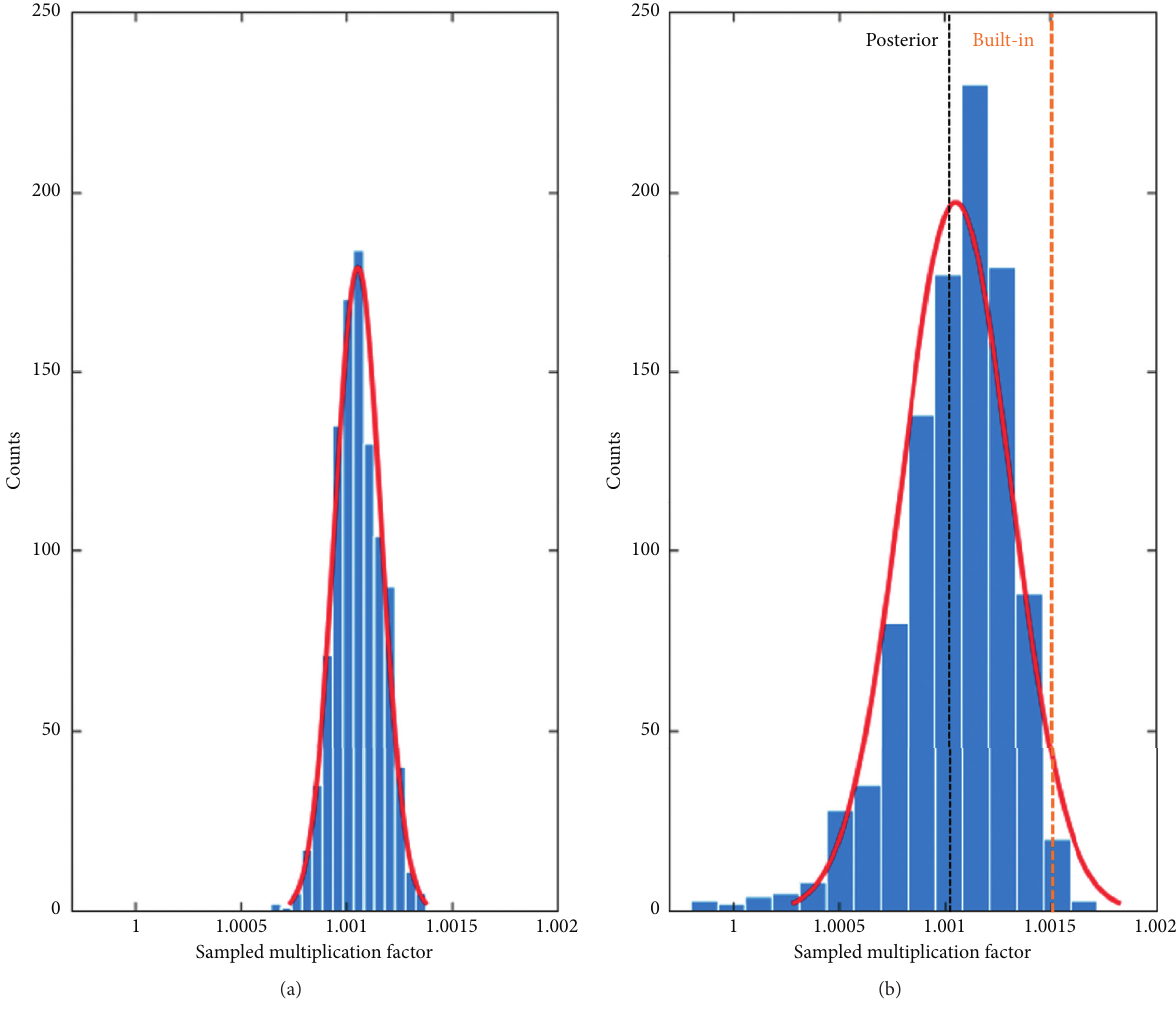
Figure 18: Histogram of 1,000 multiplication factor samples obtained at equilibrium core state. (a) Samples obtained by normal-based sampling procedures. (b) Samples obtained by lognormal-based samples procedures. Red line indicates the superimposed fitted normal density from the sampled data.